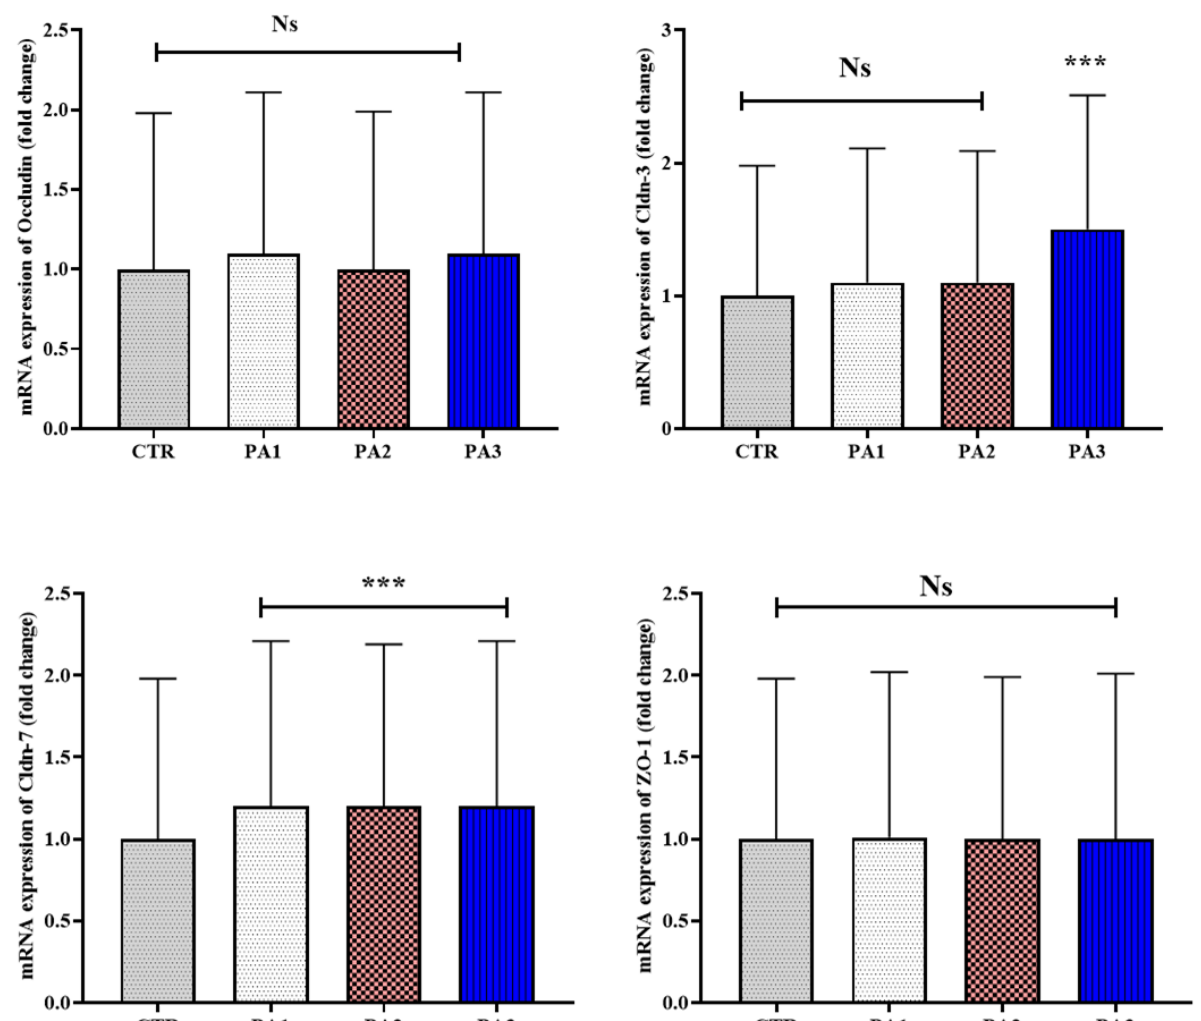
Figure 2. Intestinal-integrity-related gene ( Occludin ; Claudin-3 ; Claudin-7 ; Zona occluden-1 , Zo-1 ) expressions in common carp administered with P. australis extract at 0.0 (CTR), 100 (PA1), 200 (PA2), and 400 (PA3) mg/diet for 56 days. Data are presented as mean ± SE ( n = 12). Ns indicate no significant differences between groups, while *** indicates high significance at 0.001 ( p < 0.001).